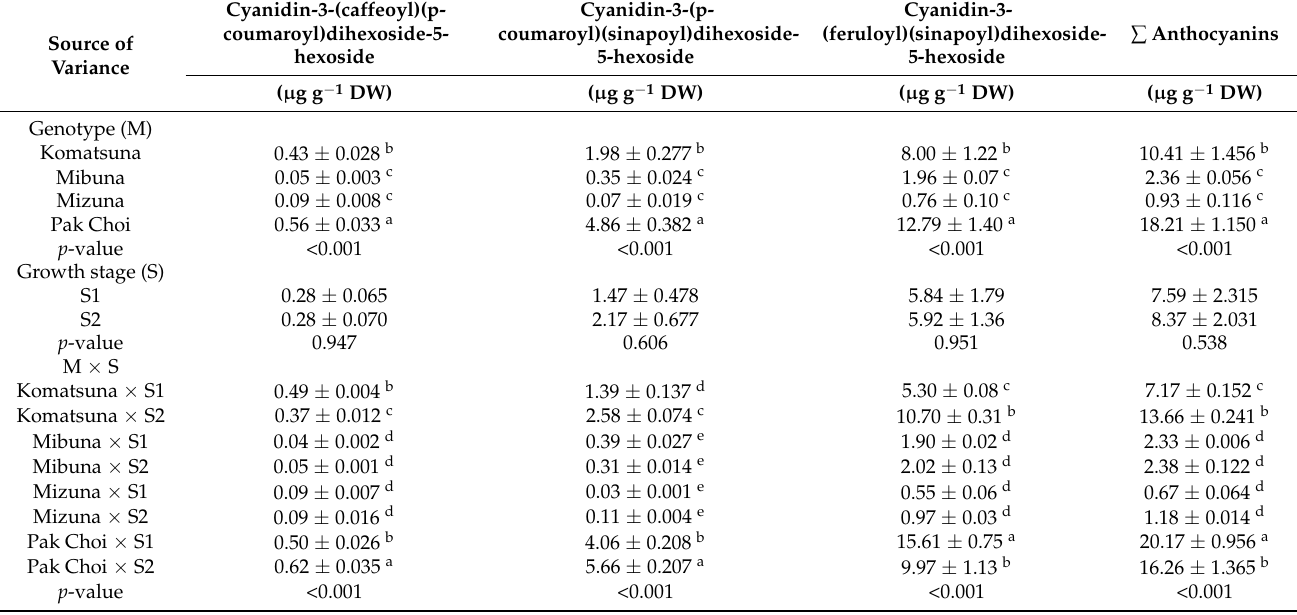
Different letters within each column indicate significant differences according to a Tukey–Kramer HSD test ( p =